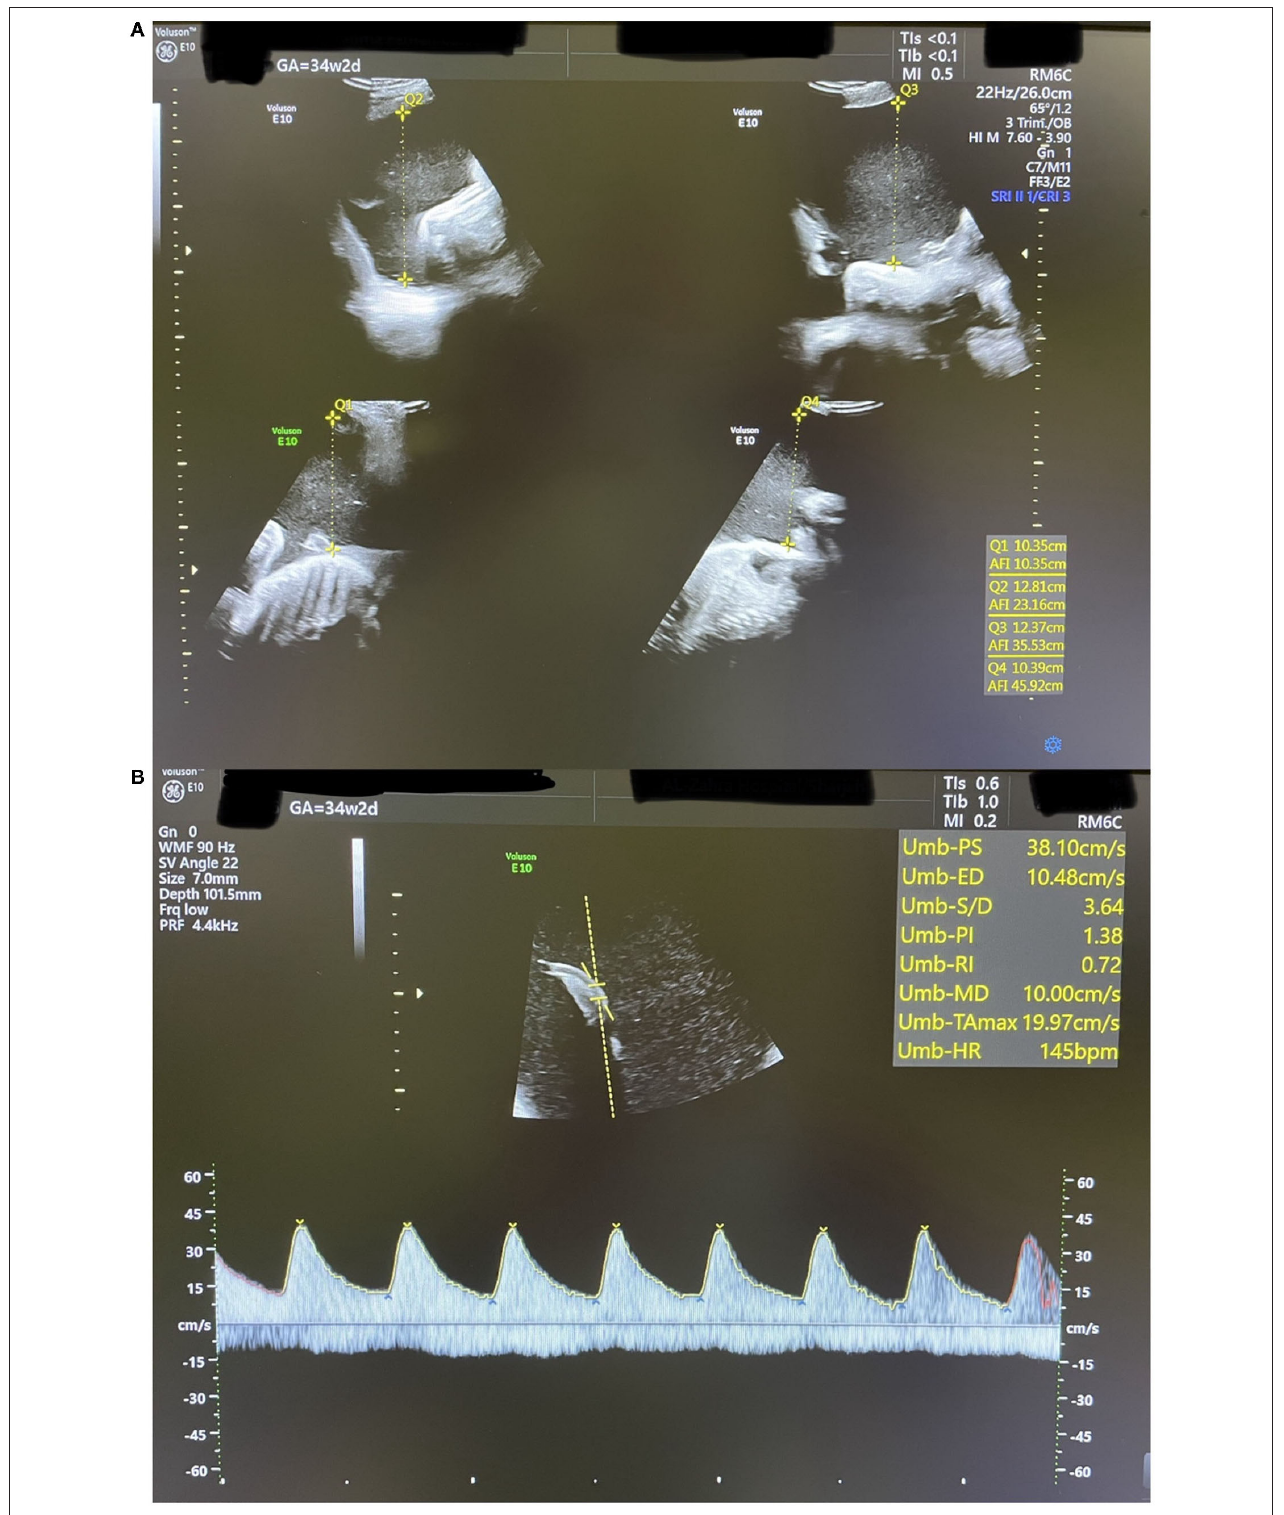
FIGURE 4 | An ultrasound scan showing findings at 34 weeks + 2 days (A) : AFI of 45.9cm. (B) : Umbilical artery Doppler waveform with increased PI above the 99th centile.